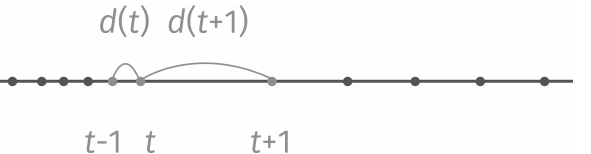
Figure 3. Illustration of the calculation of the function for neighbor-based minimization method.